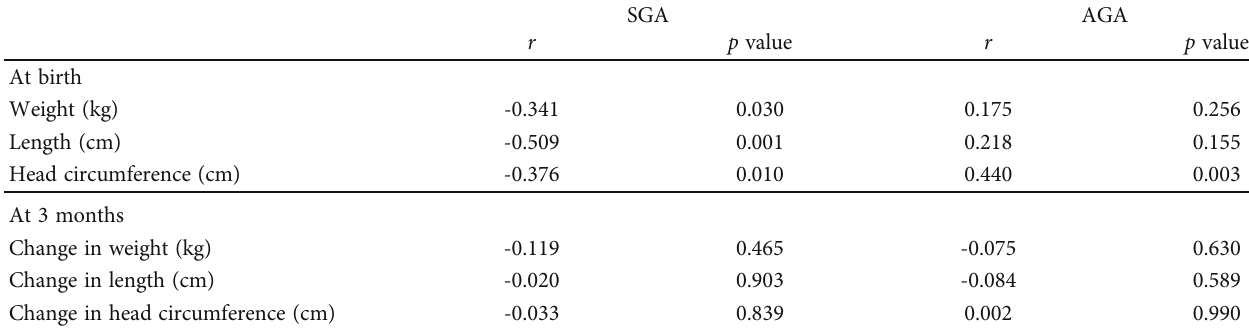
Table 2: Correlation between acylated ghrelin concentrations and anthropometric parameters at birth and at 3 months.